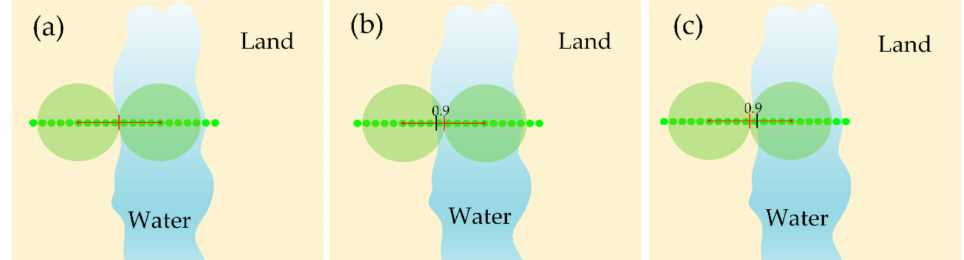
Figure 14. Schematic diagram of the footprint location. ( a ) shows the footprint location under ideal conditions. ( b , c ) show the situation with the largest deviation. The red vertical line is the central location of the water footprint spot and the land spot. The black vertical line is the water–land